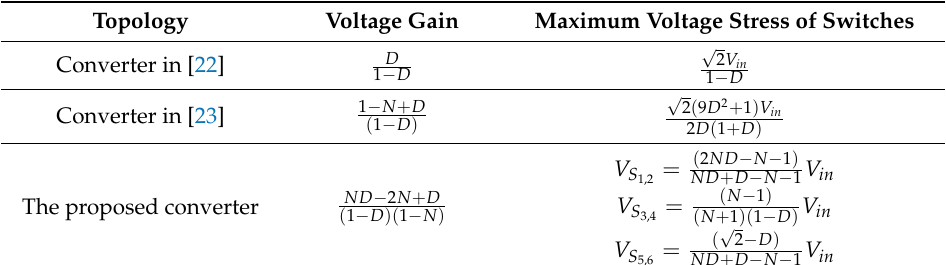
Table 1. Governing equations of the existing converters and the proposed converter.